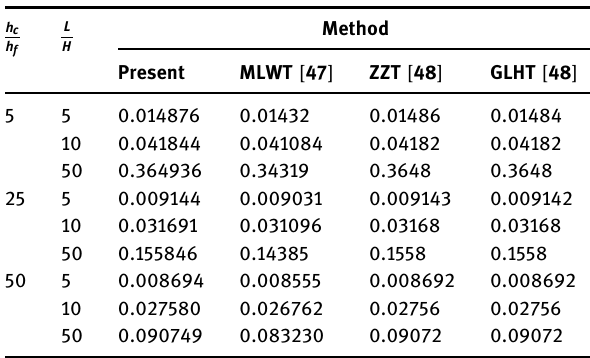
Table 5: The non - dimensional critical buckling loads (